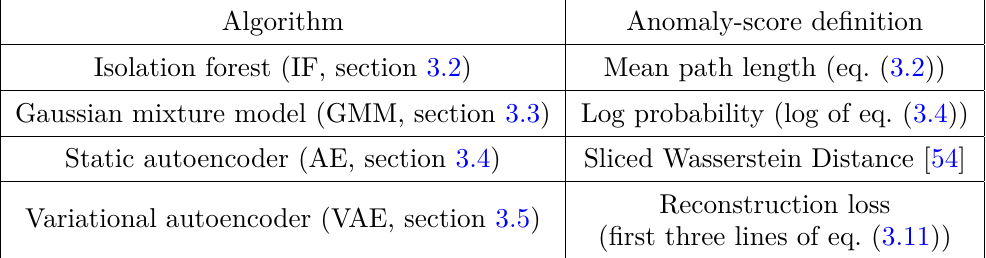
Table 3 . Summary of the considered ML algorithms and the definition of their anomaly